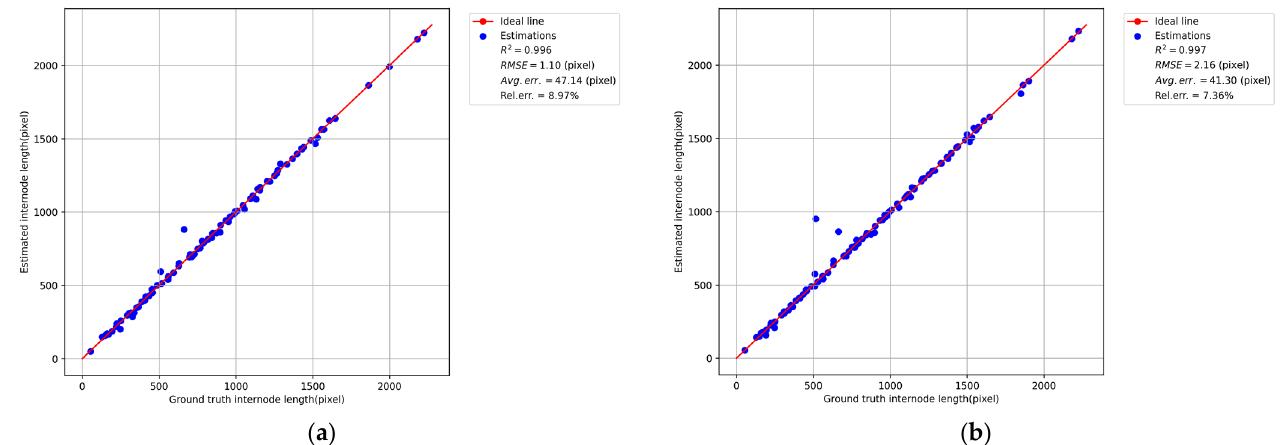
Figure 12. The relationship between the estimated internode length and the ground truth internode length for 30 images containing 3 categories of crops. ( a ) YOLOv5s, ( b ) improved YOLOv5.